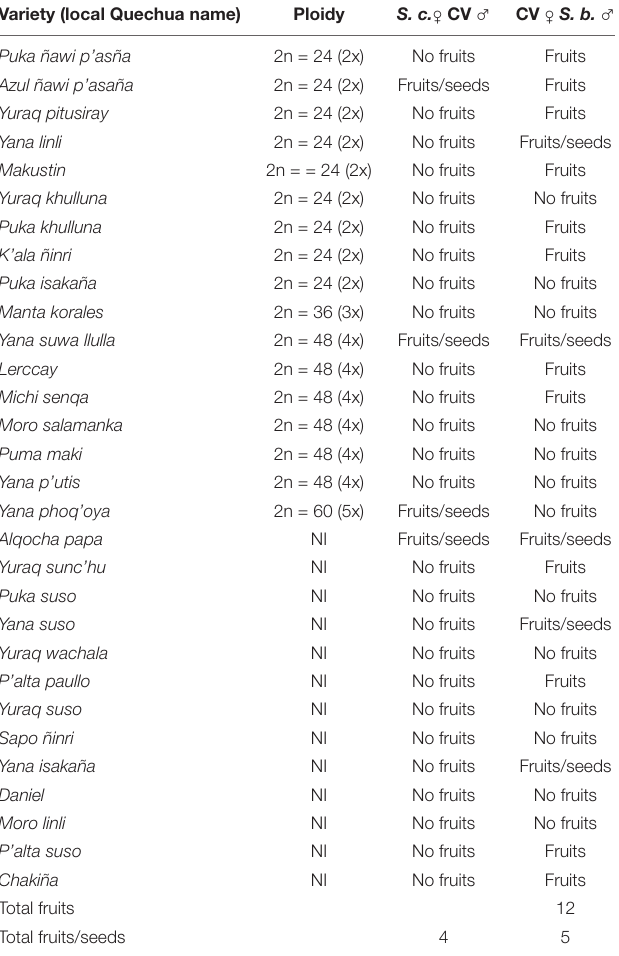
TABLE 9 | Cultivated crop varieties (CV) of potatoes ( Solanum tuberosum subsp. tuberosum ) and their ploidies reported by Márquez-Castellanos et al. (2019), used in the experimental crosses with the diploid Solanum candolleanum (S. c.) (Spooner et al., 2014). Variety (local Quechua